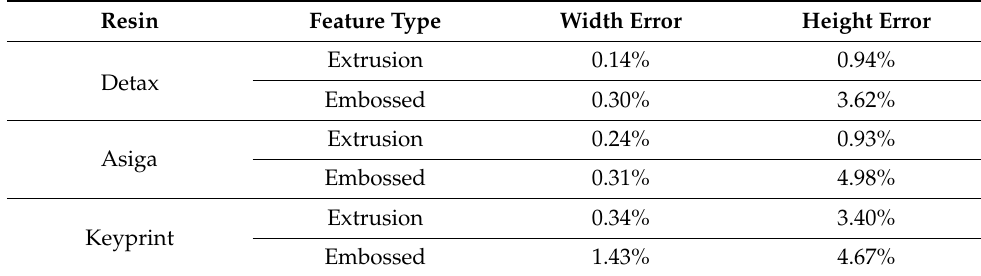
Table 3. Width and height error for extruded and embossed spiral printed with the three different types of resin.